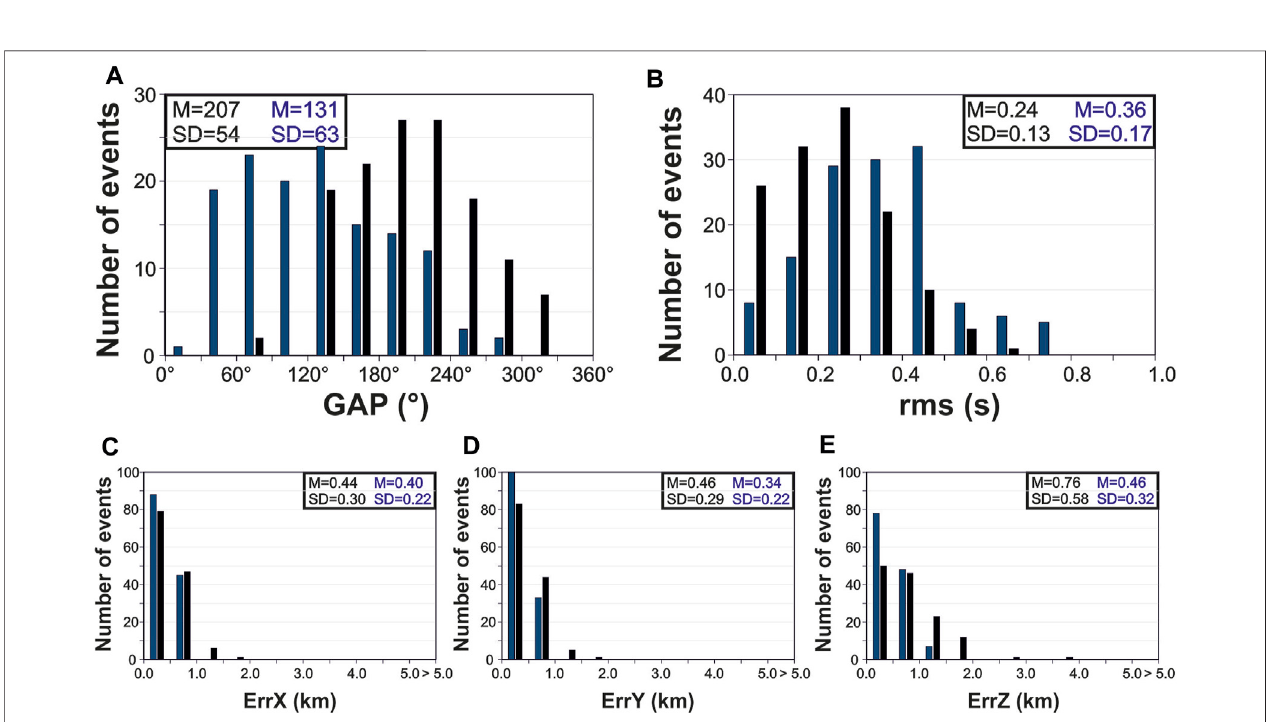
FIGURE 6 | Statistical analysis in terms of Mean (M) and Standard Deviation (SD) values computed on GAP (A) , rms (B) , and (C, D, E) horizontals (ErrX, ErrY), and vertical (ErrZ) errors for location with OBS travel times (blue histograms) and without OBS travel times (black histograms). The presence of an offshore network contributed to an improved relocation